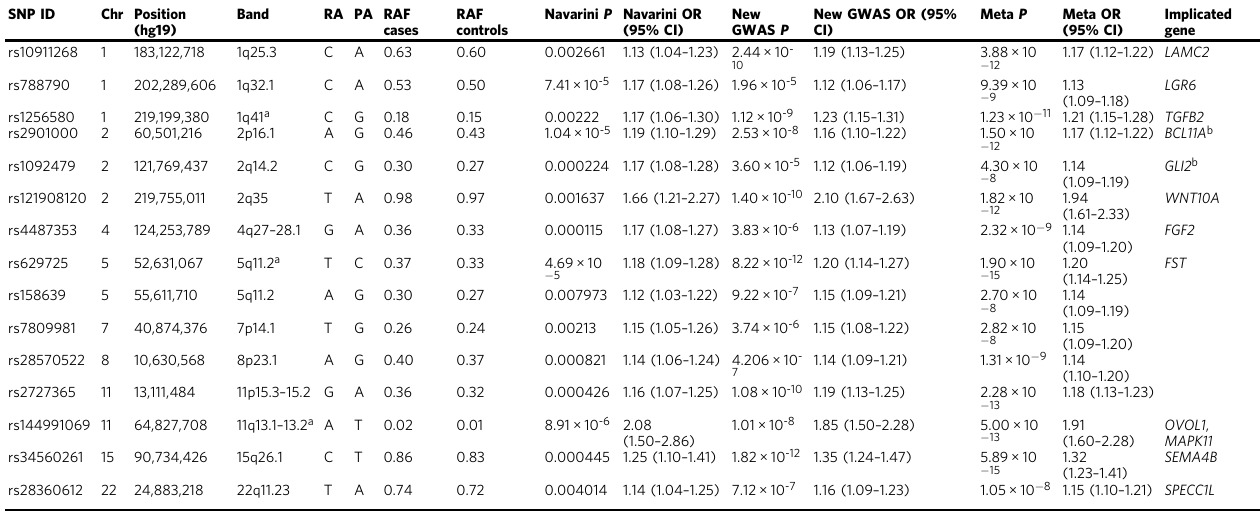
Chr: chromosome, RA: risk allele, PA: protective allele, RAF: risk allele frequency, OR: odds ratio, 95% CI: 95% con fi dence interval a Previously reported acne susceptibility locus (Navarini et al.) b Implicated through relationship to the sparse hair (MP:0000416) gene-set by